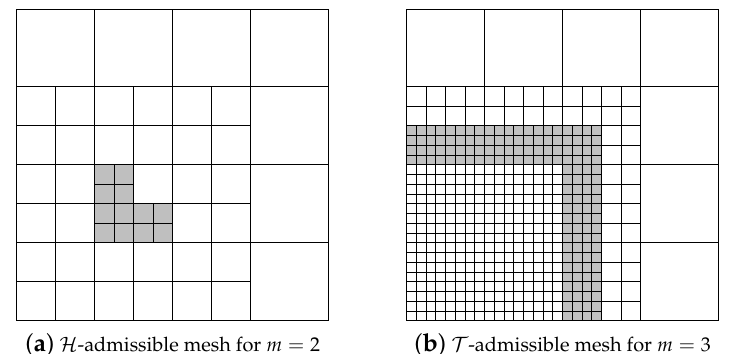
Figure 2. Examples of degree p = ( 2,2 ) of meshes that are admissible, but not strictly